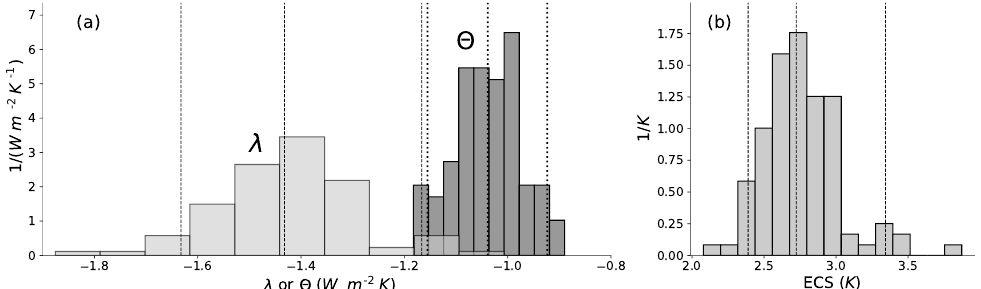
Figure 2. Probability density functions (PDFs) of (a) λ (lighter) and (cid:50) (darker) and (b) ECS derived from the members of the MPI-ESM1.1 historical ensemble. The vertical lines are the 5th, 50th, and 95th percentile of each distribution.